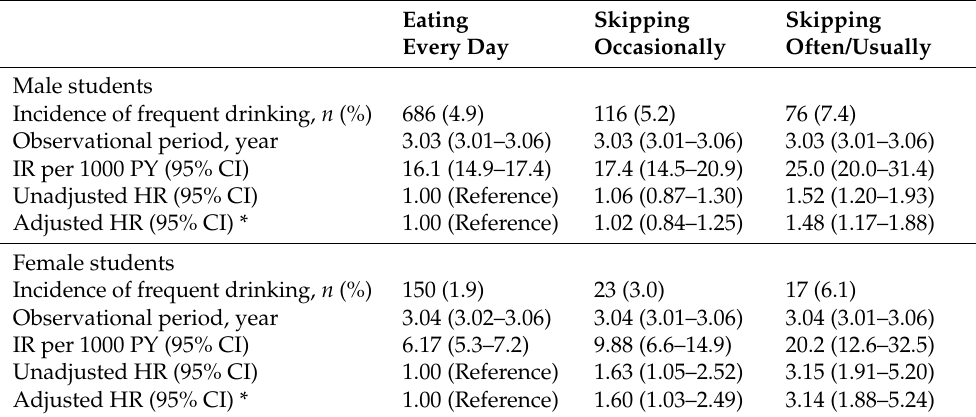
Table 3. Associations between breakfast frequency and the incidence of frequent drinking.